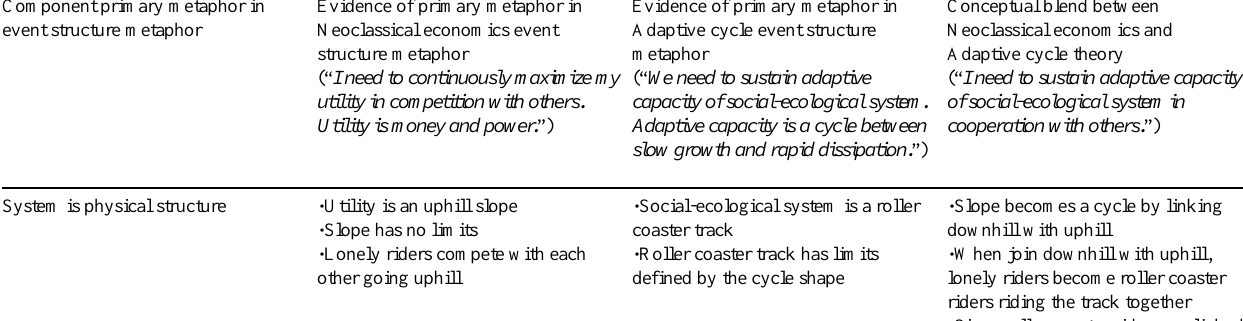
Table 1 . Transformation of event structure metaphors into conceptual blends between neoclassical economics and adaptive cycle